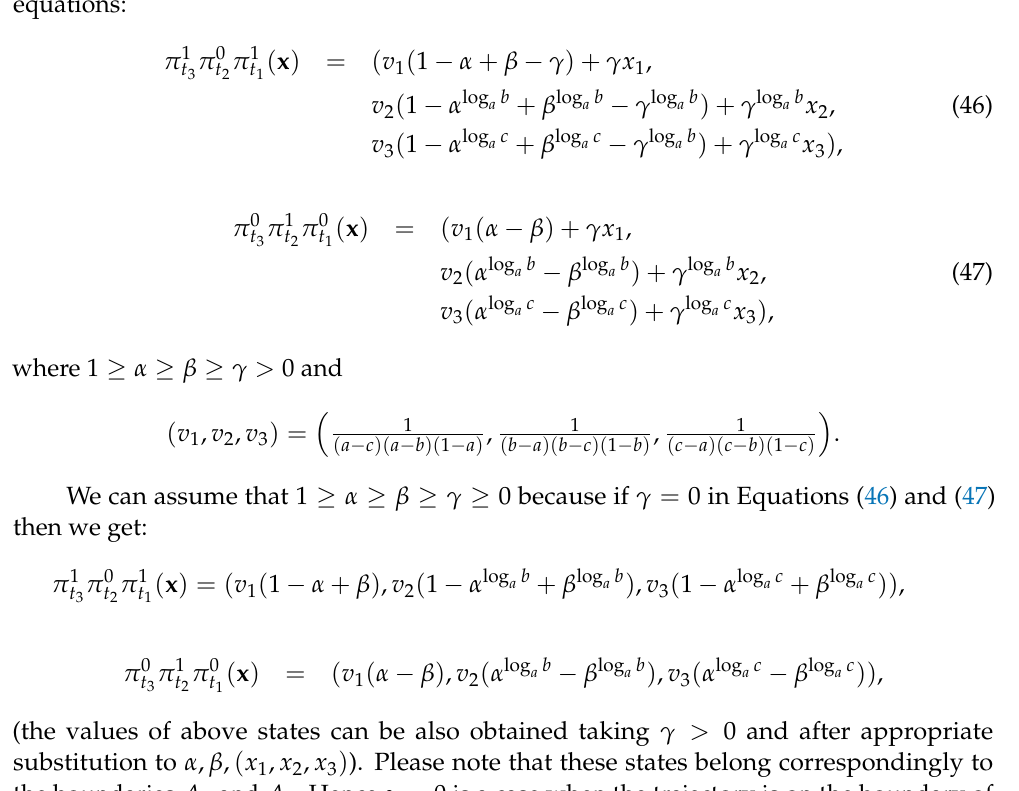
Figure 5. This figure presents all states of the stochastic process (36) with a = 1 two switches. The red color represents the states given by the Formula (45) representing trajectories of the process starting with i = 0 while the blue color represents the states given by the Formula (44) representing trajectories of the process starting with i =